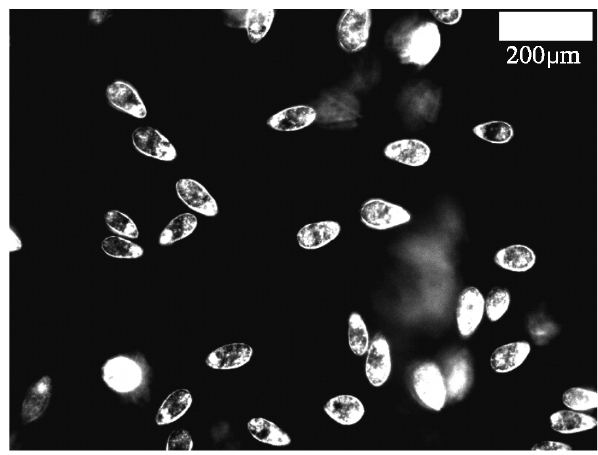
Figure 1. Image of Tetrahymena cells trapped and swimming at a water-air interface (WAI).